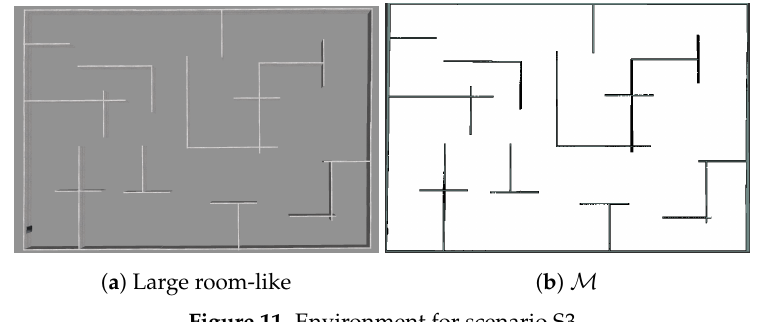
Figure 11. Environment for scenario